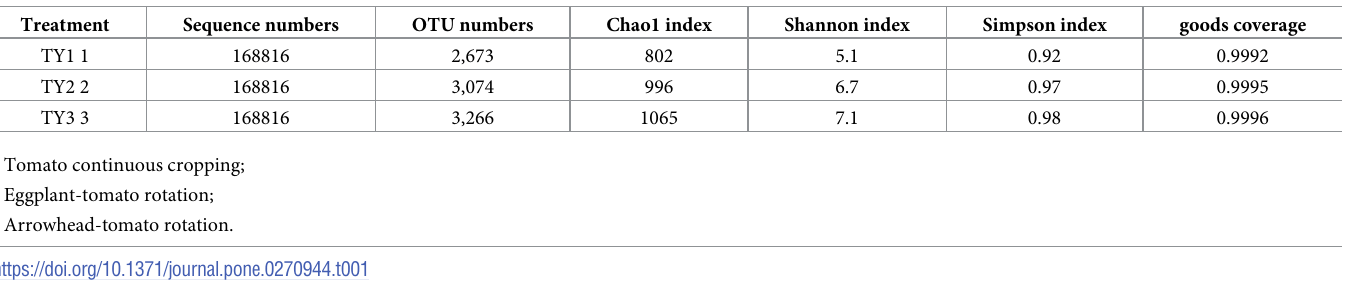
Table 1. Soil bacterial diversity indices of different planting